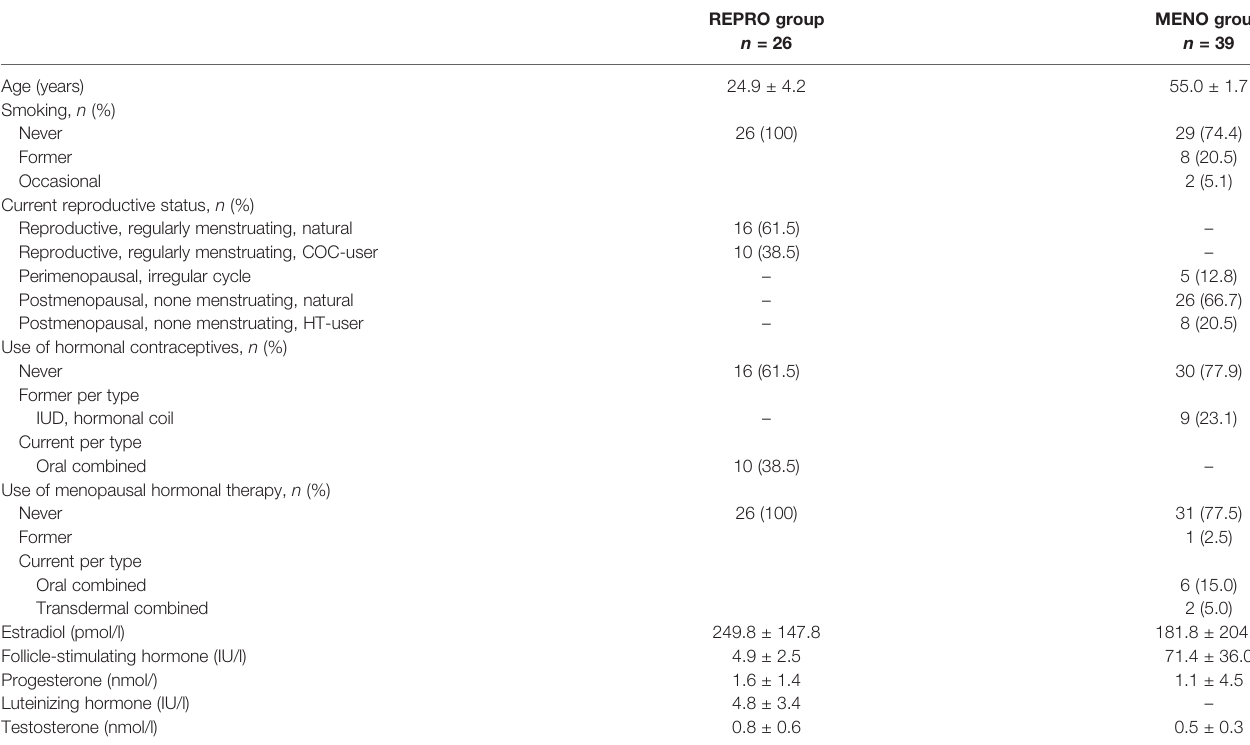
TABLE 1 | Descriptive characteristics of the study